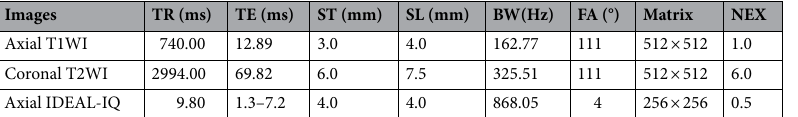
Table 2. MRI scan parameters. T1WI T1-weighted imaging, T2WI T2-weighted imaging, TR time of repetition, TE echo time, ST slice thickness, SL slice increment, BW band width, FA flip angle, NEX number of